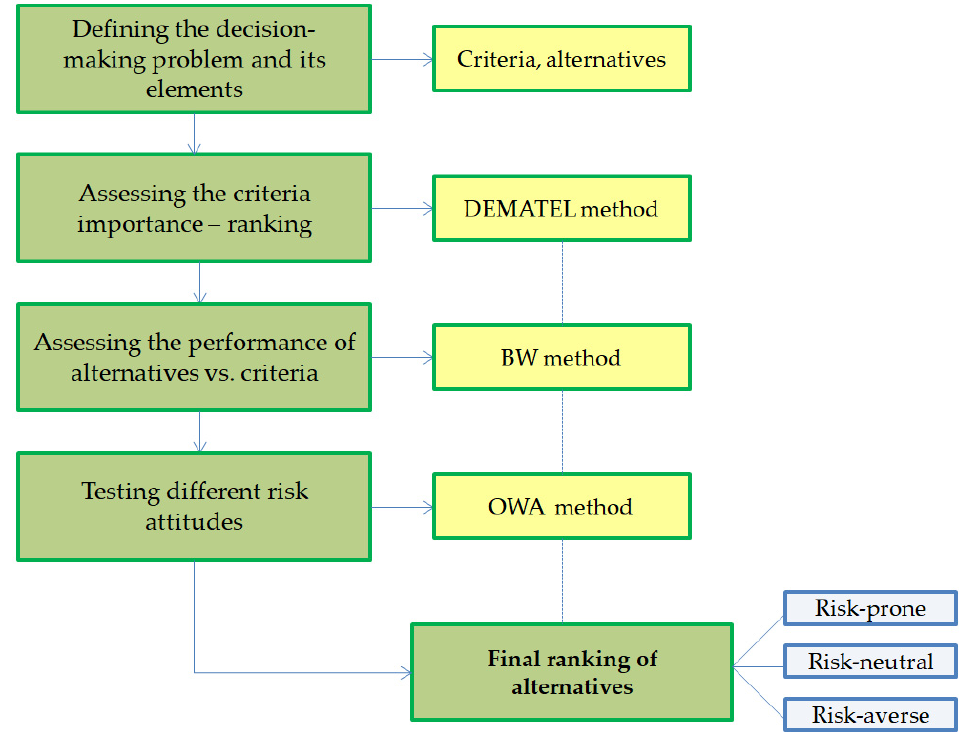
Figure 1. Proposed decision-making framework.